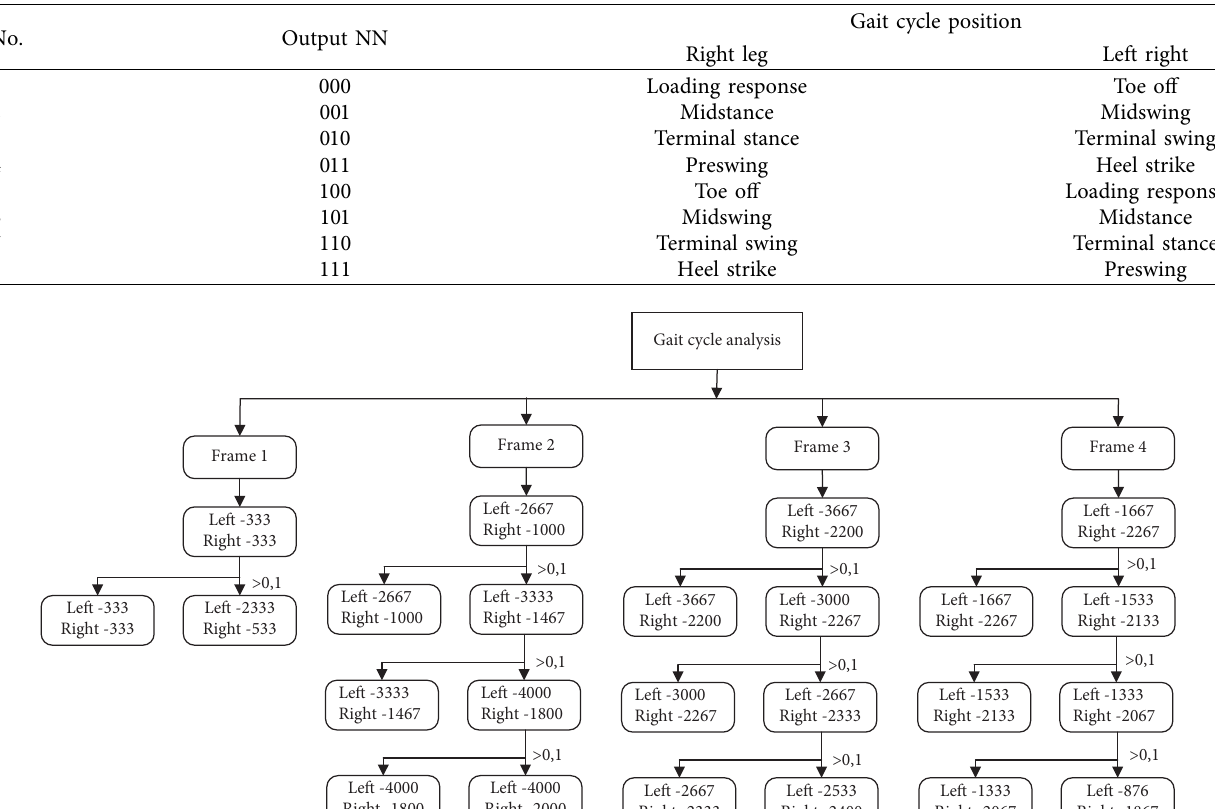
Figure 5: Walking gait cycle used in the learning process. Table 2: Output of the NN frames.